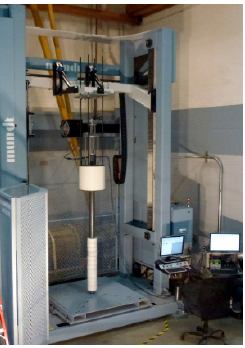
Figure 2. Testing in the Linear Test Bed (LTB). The Linear Test Bed has a maximum stroke of 2 m, force capacity of 20 kN, and a maximum speed of 1